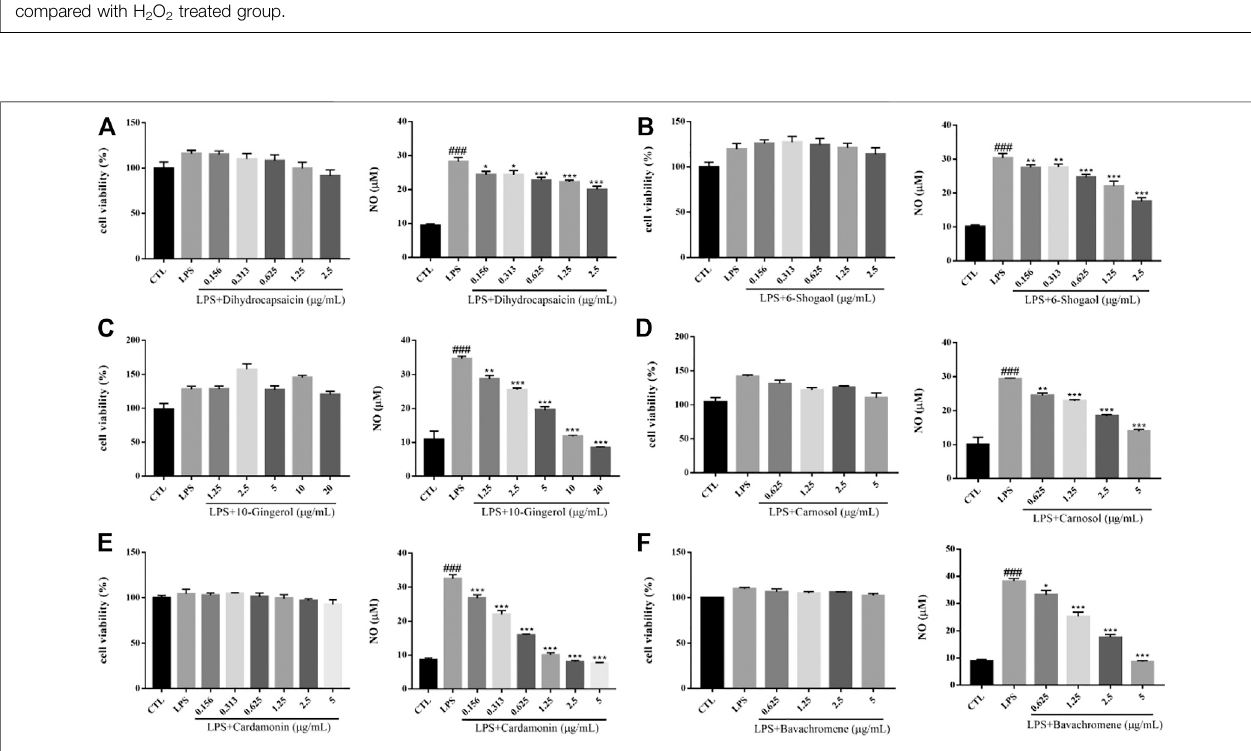
FIGURE 13 | Various constituents suppressed LPS-induced cytotoxicity in BV2cells. Cells were pre-treated with different concentrations of Dihydrocapsaicin (A) , 6-Shogaol (B) , 10-Gingerol (C) , Carnosol (D) , Cardamonin (E) , Bavachromene (F) or 0.1% DMSO for 2 h and then incubated with or without LPS (500 ng/ml) for 24 h and the cell viability was detected by MTT assay ( n (cid:1) 3). NO concentration was detected by Griess reagent kit ( n (cid:1) 3). ### p < 0.001 compared with control group, * p < 0.05, ** p < 0.01, *** p < 0.001 compared with LPS treated group.